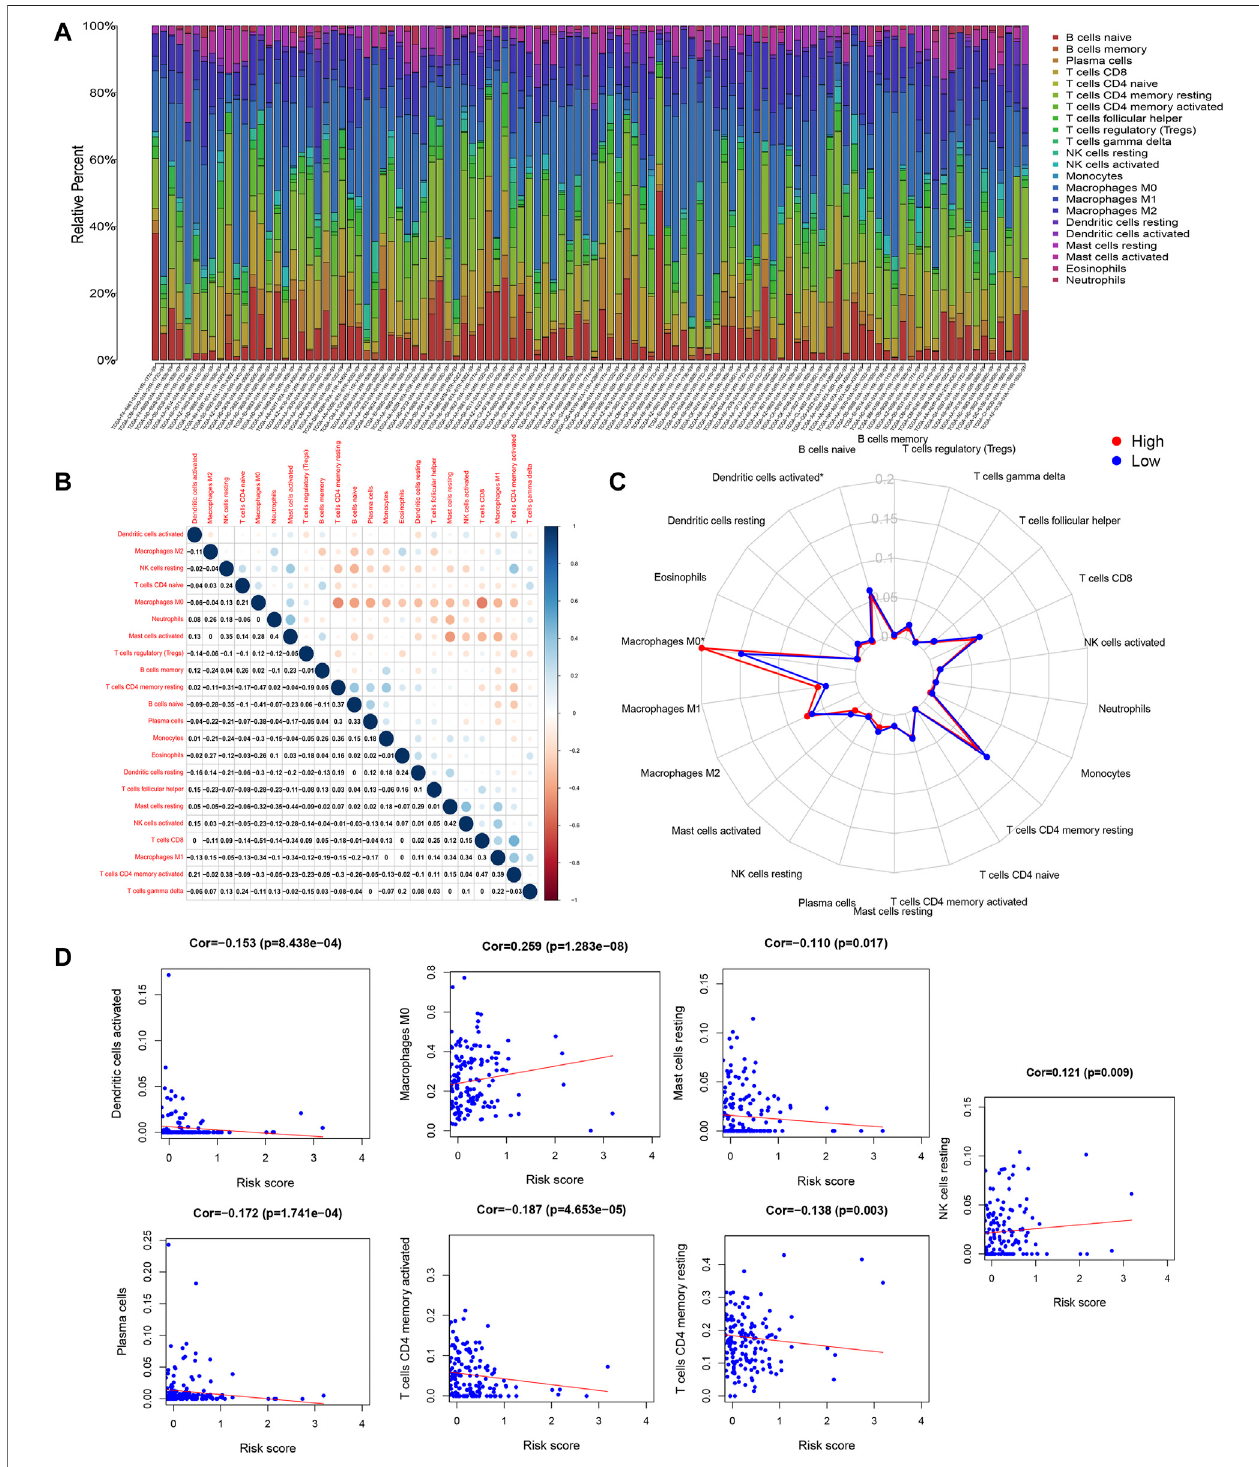
FIGURE 8 | CIBERSORT results. (A) Estimated scores of 22 immune cell subtypes. Each bar chart presented cell proportions of each patient, and different colors represented 22 types of immune cells. (B) Co-expression patterns of immune cell components. (C) The immune cell landscape between low- and high-risk groups is shown by a radar plot. Red and blue represent high RS groups and low RS groups, respectively. The expression of immune cell types between the two groups differed. (D) The relationship between the risk model score and the content of seven immune cell types.